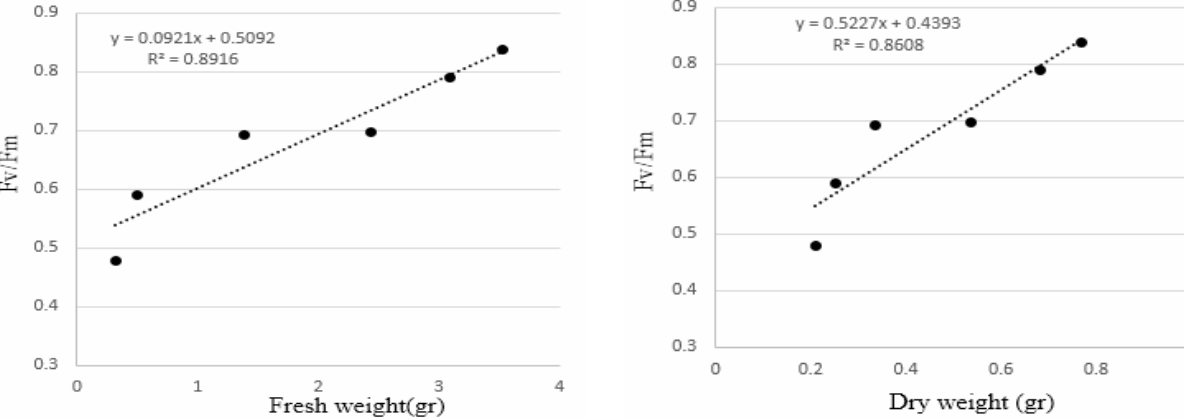
Fig. 5. Relationship between Fv/Fm parameter and fresh and dry weight at 7 days after spraying on sethoxydim only